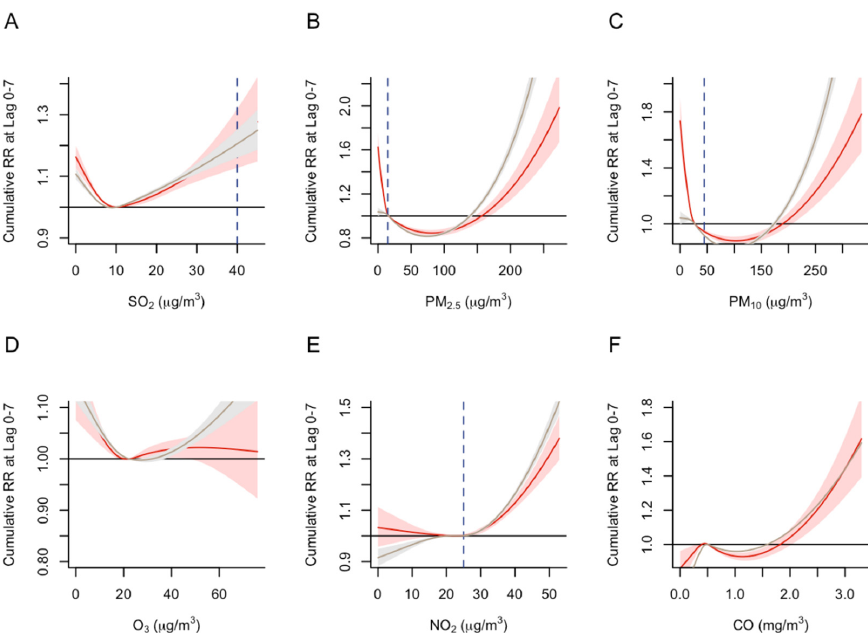
Figure 4. Association between air pollutant levels and cumulative relative risk (RR) of emergency admissions due to cardiovascular and respiratory conditions. ( A ) SO 2 levels and RR; ( B ) PM 2.5 levels and RR; ( C ) PM 10 levels and RR; ( D ) O 3 levels and RR; ( E ) NO 2 levels and RR; ( F ) CO levels and RR. The solid red line represents the modeled cumulative risk for cardiovascular-related conditions, while the solid gray line represents the modeled cumulative risk for respiratory-related conditions. The shaded areas represent the 95% confidence intervals. The horizontal solid black line represents the null value. The vertical blue dashed line represents the desired air pollutant levels indicated in the WHO air quality guidelines.